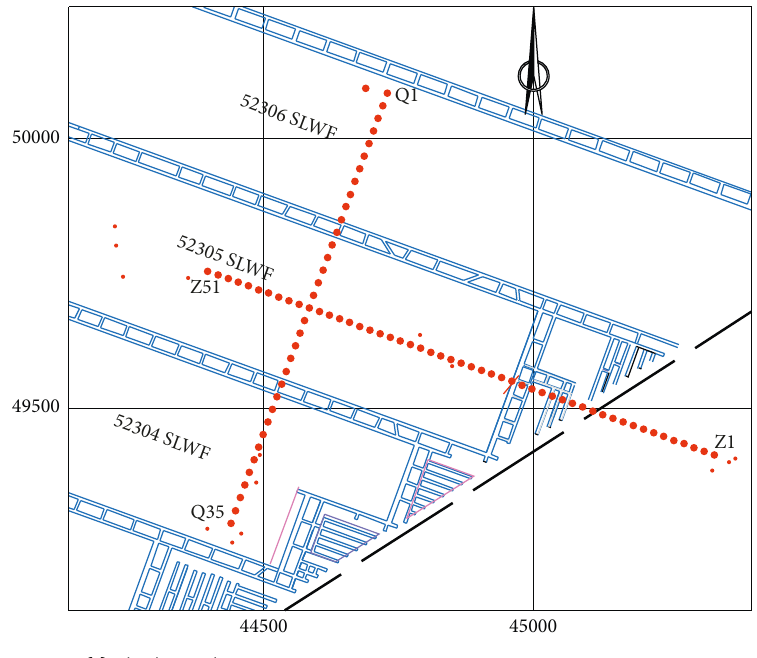
Figure 3: Layout of surface monitoring observations of 52305 SWLF.